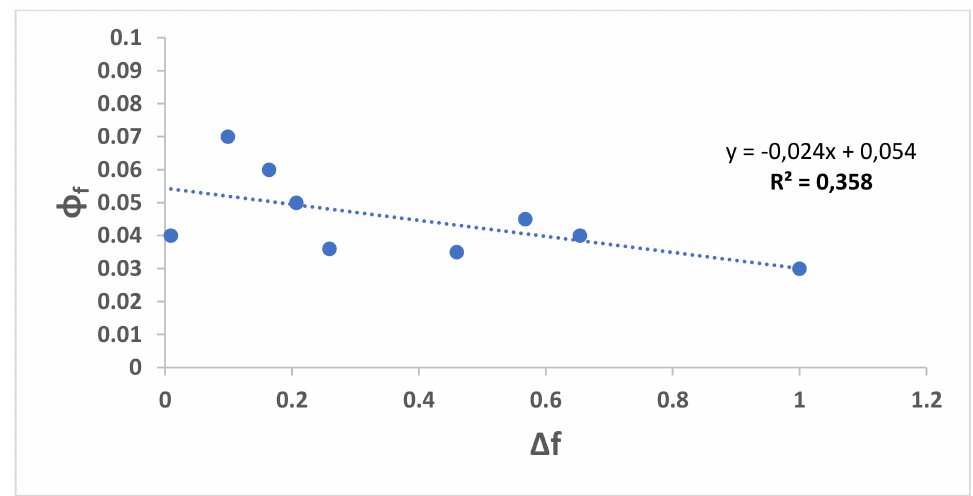
Figure 17. Variation of the fluorescence quantum yield Φ f with the solvent polarity.